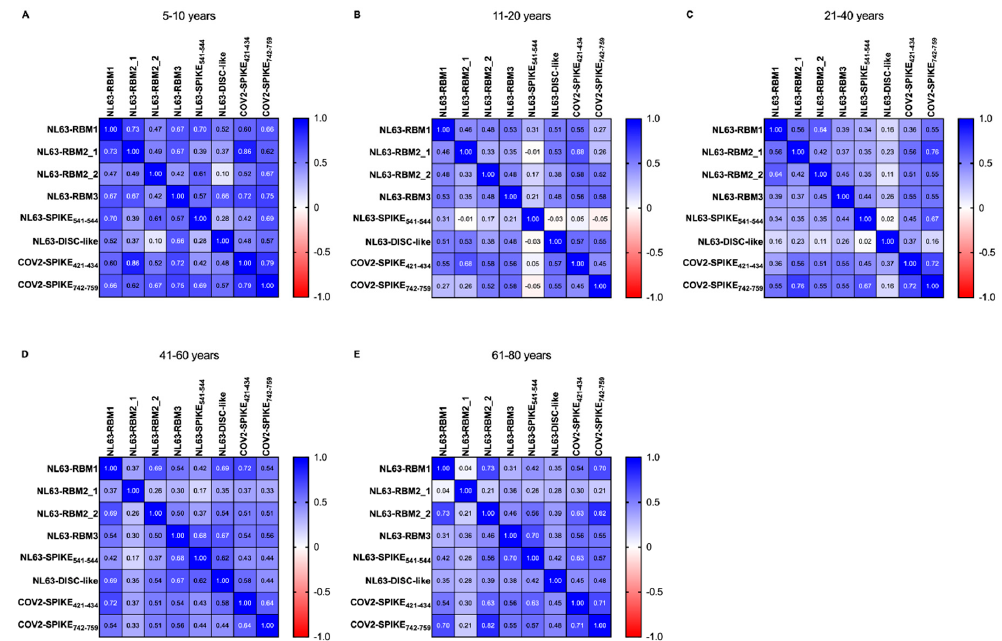
Figure 4. Heatmap displaying the r values obtained from Spearman correlation analysis performed among HCoV-NL63 and SARS-CoV-2 derived peptides used in the previous experiments in the pre-pandemic cohort divided by age groups ( A ) (5–10 years old), ( B ) (11–20 years old), ( C ) (21–40 years